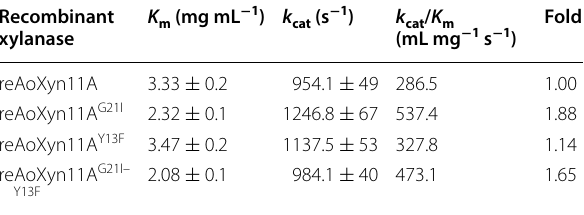
Table 2 The kinetic parameters of reAoXyn11A and its three